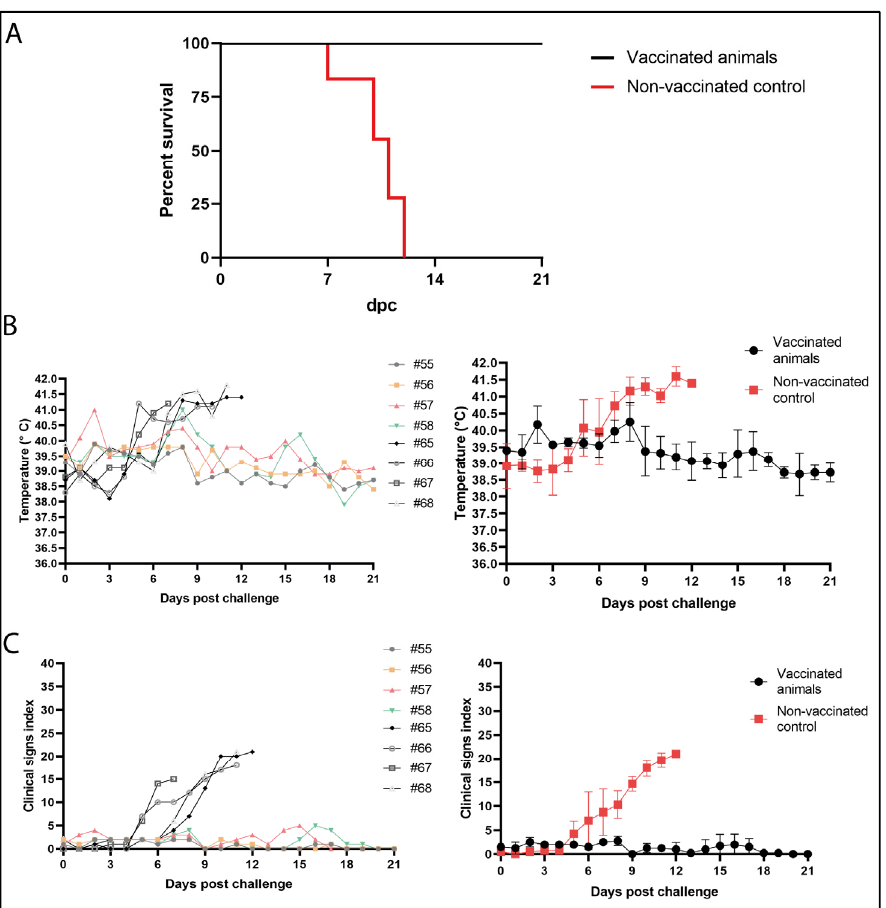
Figure 5. Clinical challenge of pigs inoculated with Arm- ∆ CD2v- ∆ A238L LAV candidate. ( A ) Survival analysis of vaccinated/challenged pigs (black) and non-vaccinated/challenged positive control pigs (red). ( B ) Individuals ( right ) or average ( left ) daily temperatures of pigs receiving a 10 2 pfu dose of Arm- ∆ CD2v- ∆ A238L, followed after 28 days by challenge with 10 2 HAD 50 of virulent Korean Paju strain (animals #55–58; average in black); and non-vaccinated control pigs also challenged with virulent Korean Paju strain (animals #65–68, average in red). ( C ) Clinical scores of individual pigs ( right ) or average ( left ) during the challenge phase of vaccinated animals (animals #55–58; average in black) and non-vaccinated control pigs (animals #65–68, average in red). Scores were determined based on several parameters (see Table